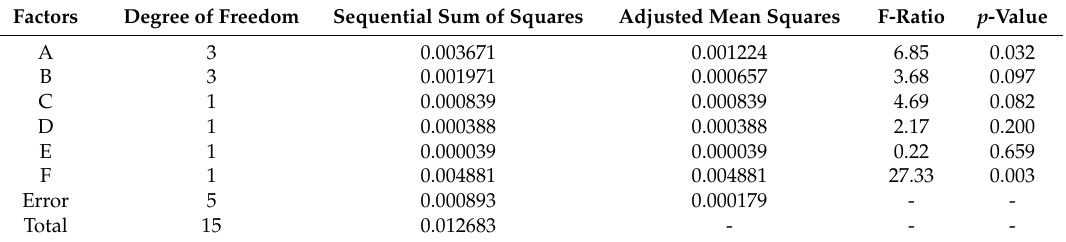
Table 4. Analysis of variance (ANOVA) of the ratio for the machining micro-diameter.